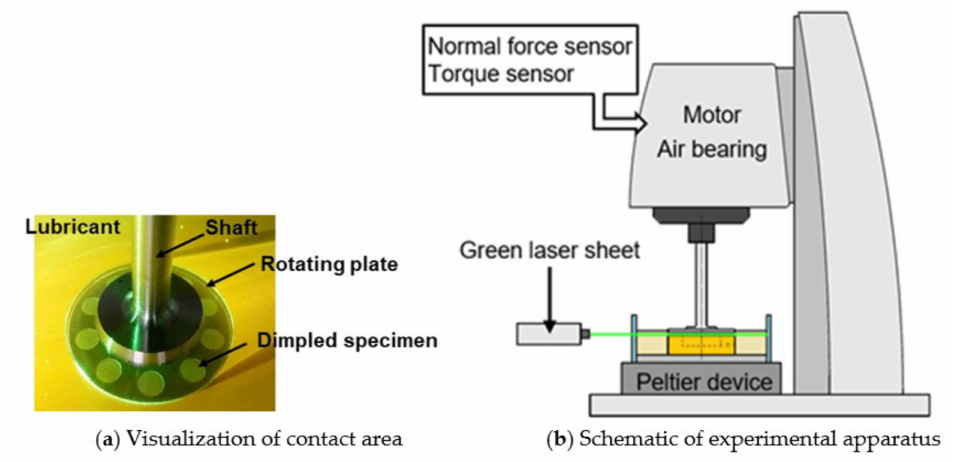
Figure 1. Experimental apparatus; contact area is lighted by a green laser for